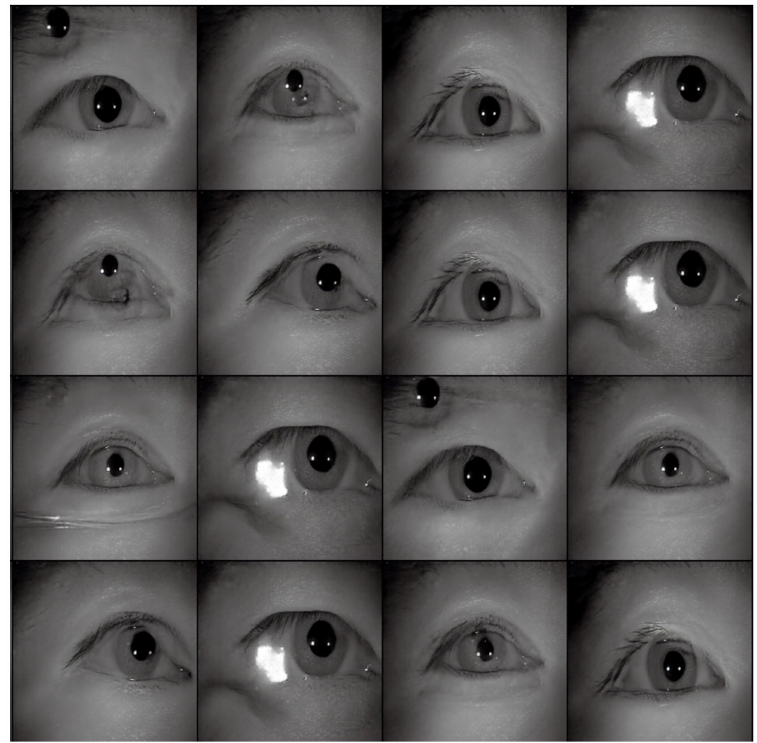
Figure 21. The example of generated images by Minaee and Abdolrashidi [70].